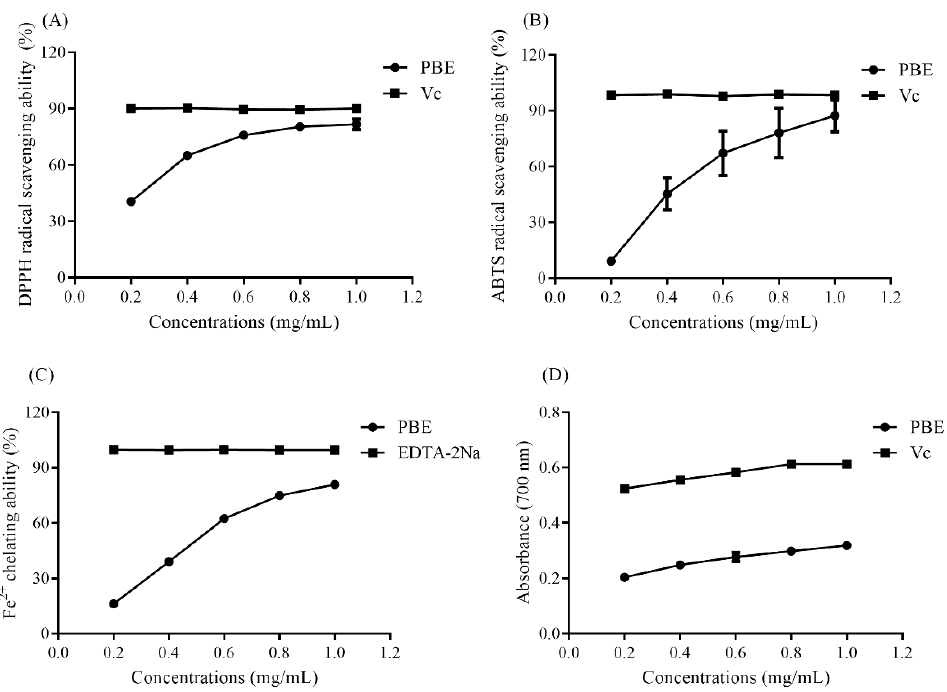
Figure 4. The antioxidant ability of PBE on ( A ) DPPH radical scavenging ( B ) ABTS radical clearance ( C ) Fe 2+ chelating capacity and ( D ) the total reducing power.